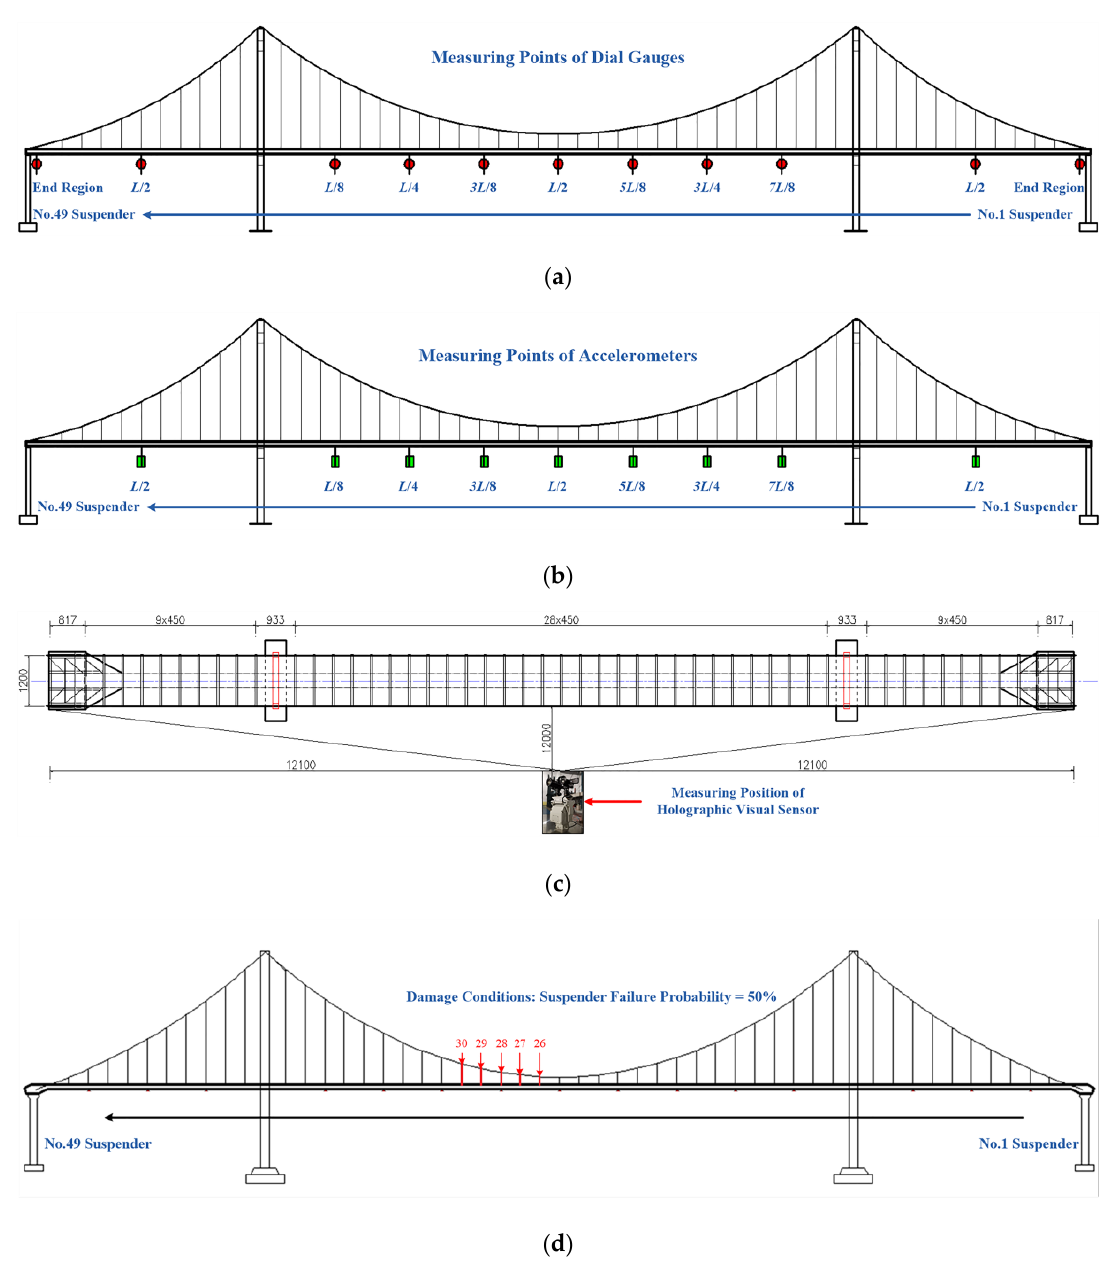
Figure 9. Sensor layout: ( a ) measuring points of dial gauges; ( b ) measuring points of accelerometers; ( c ) measuring position of holographic visual sensor (units: mm); ( d ) manual damages.